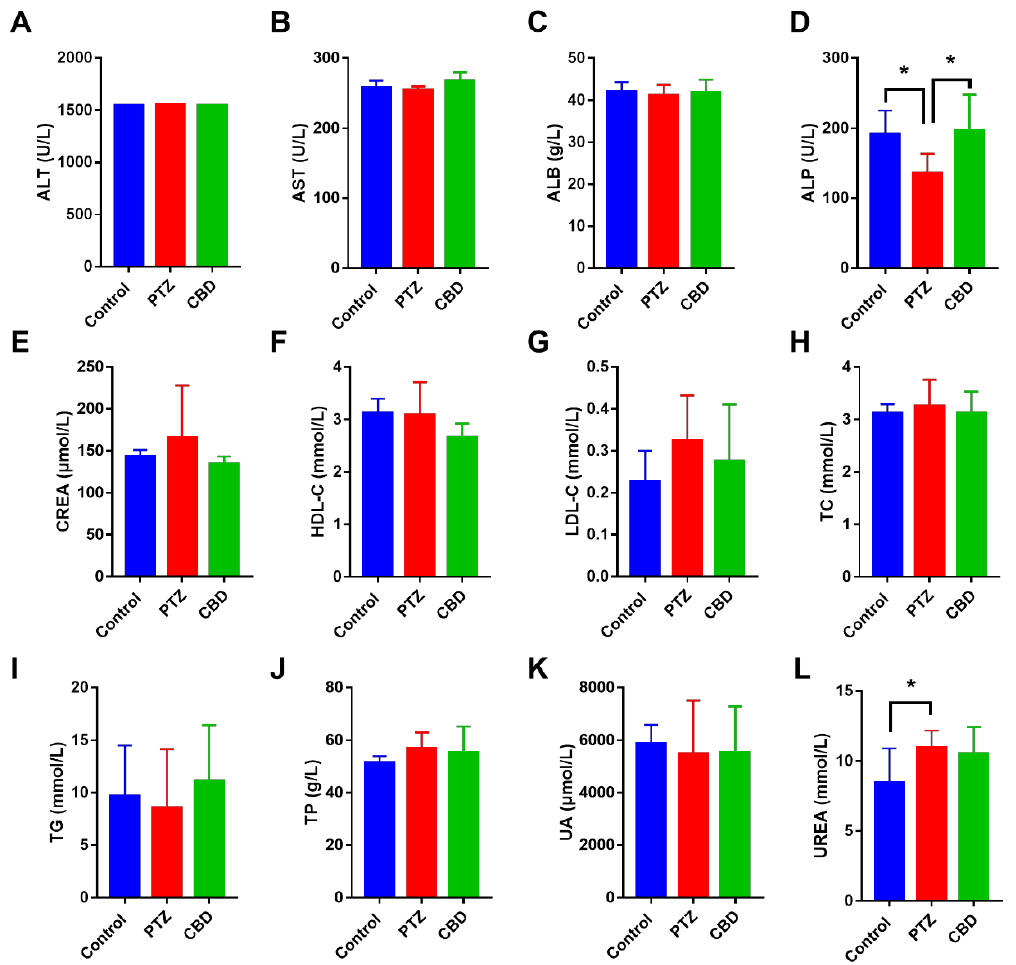
Figure 2. The blood biochemistry of mice in different groups. ( A – L ) The levels of glutamic - pyruvic transaminase (ALT), glutamic-oxaloacetic transaminase (AST), albumin (ALB), serum alkaline phos- phatase (ALP), creatinine (CREA), high-density lipoprotein (HDL-C), low density lipoprotein (LDL-C), total cholesterol (TC), triglyceride (TG), total protein (TP), uric acid (UA), and urea in serum, n = 10. * p < 0.05.